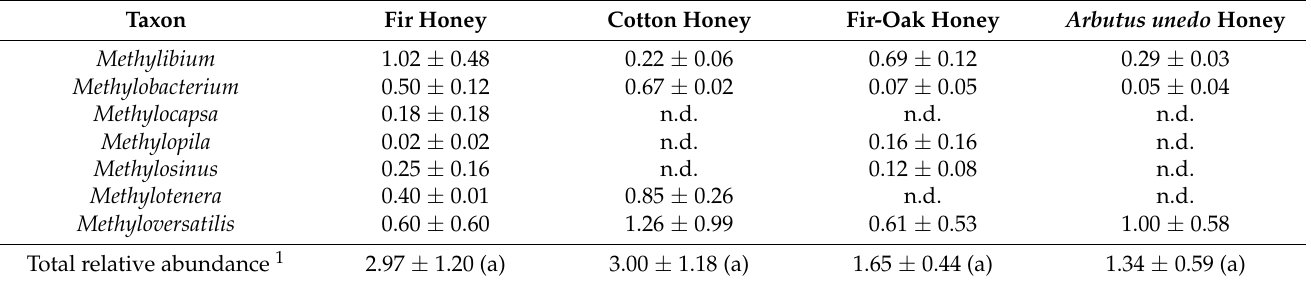
Table 3. Relative abundance of methylotrophic bacteria identified in the examined honey